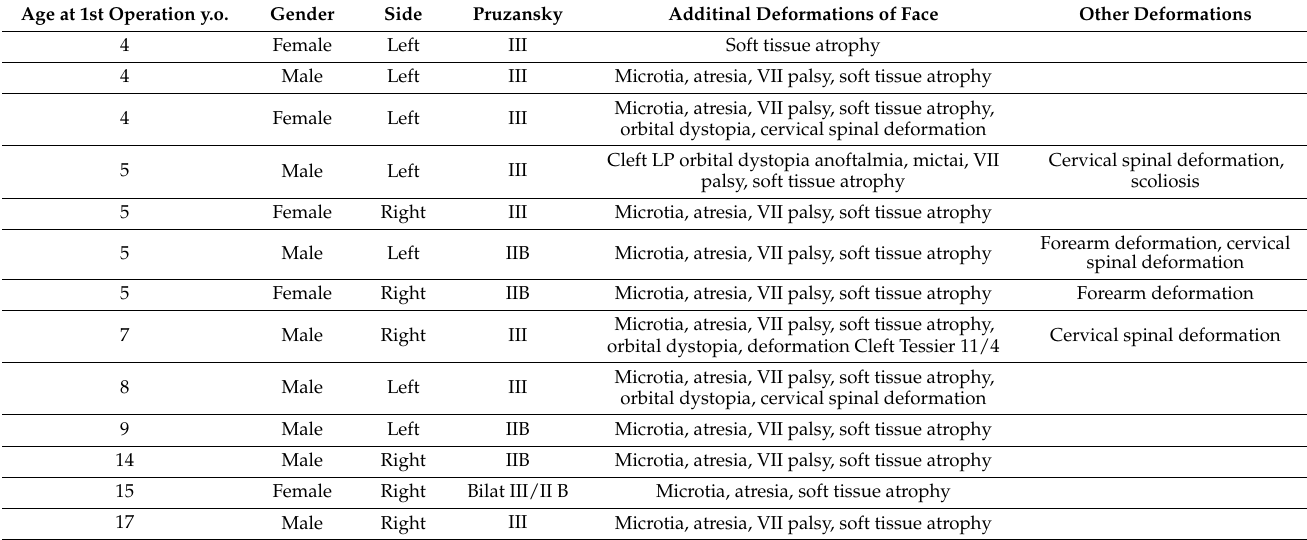
Table 1. Characteristics of patients with HFM based on age, gender, side of deformity, determination of mandibular deformity based on Pruzansky classification, and determination of additional facial and general developmental